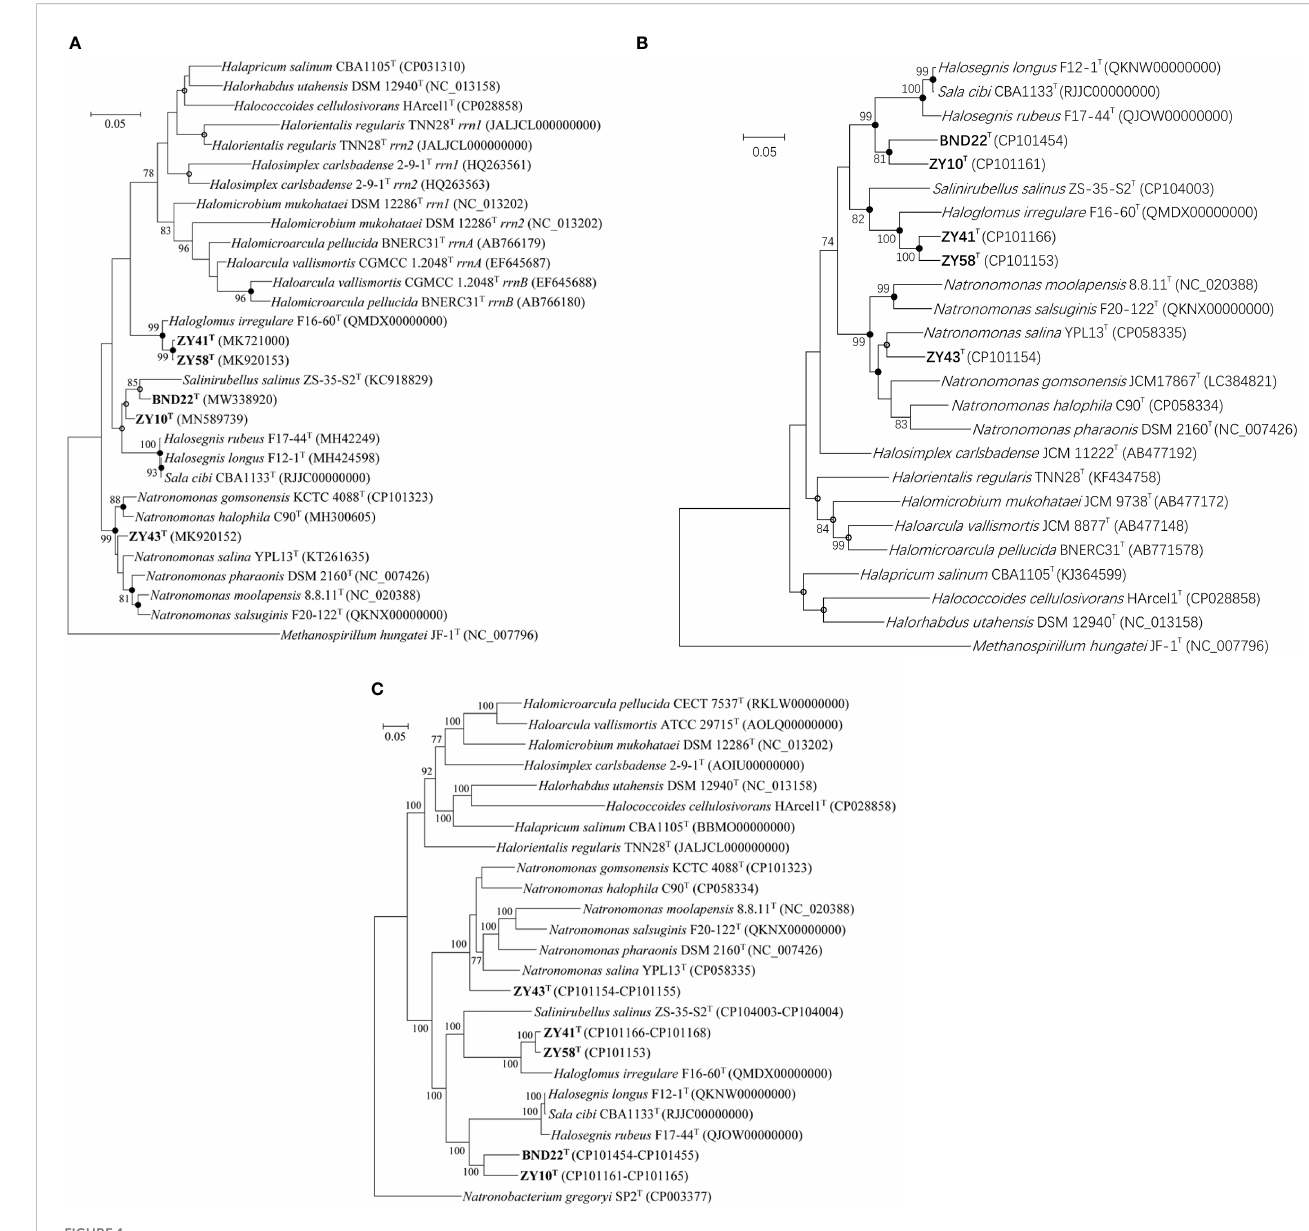
FIGURE 1 ML phylogenetic tree reconstructions based on 16S rRNA gene sequence (A) , rpoB ′ gene sequence (B) and 122 conserved archaeal protein marker genes (C) , showing the relationship among strains BND22 T , ZY10 T , ZY41 T , ZY58 T , ZY43 T and related species within Haloarculaceae. The numbers at the nodes represent bootstrap values of 1,000 replicates and support ≥ 70% bootstrap. Filled circles highlight branches that were supported by the neighbour- joining, maximum-likelihood and maximum-parsimony algorithms. Empty circles highlight branches that were supported by the maximum-likelihood and maximum-parsimony algorithms or the maximum-likelihood and neighbour-joining algorithms. The bar represents expected substitutions per nucleotide